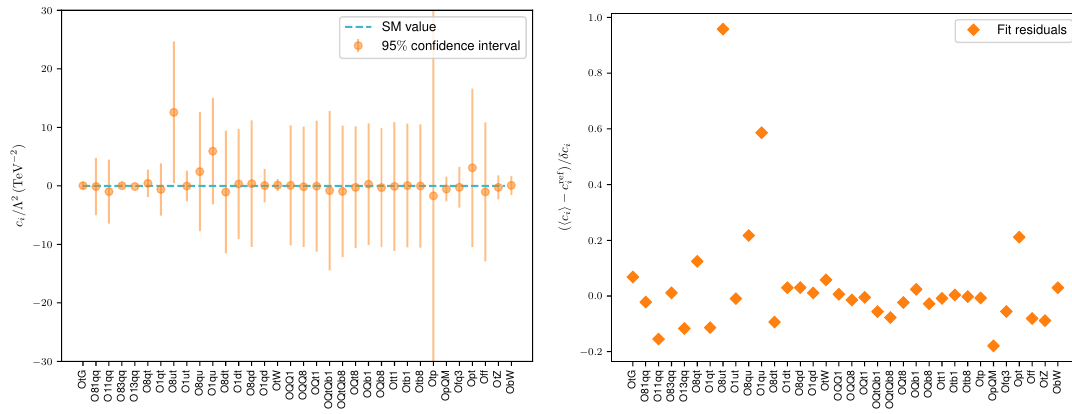
Figure 7 . Left: the values of the SMEFT degrees of freedom and their uncertainties, for the L2 closure test in the BSM scenario where one has set c 8 corresponding (cid:12)t